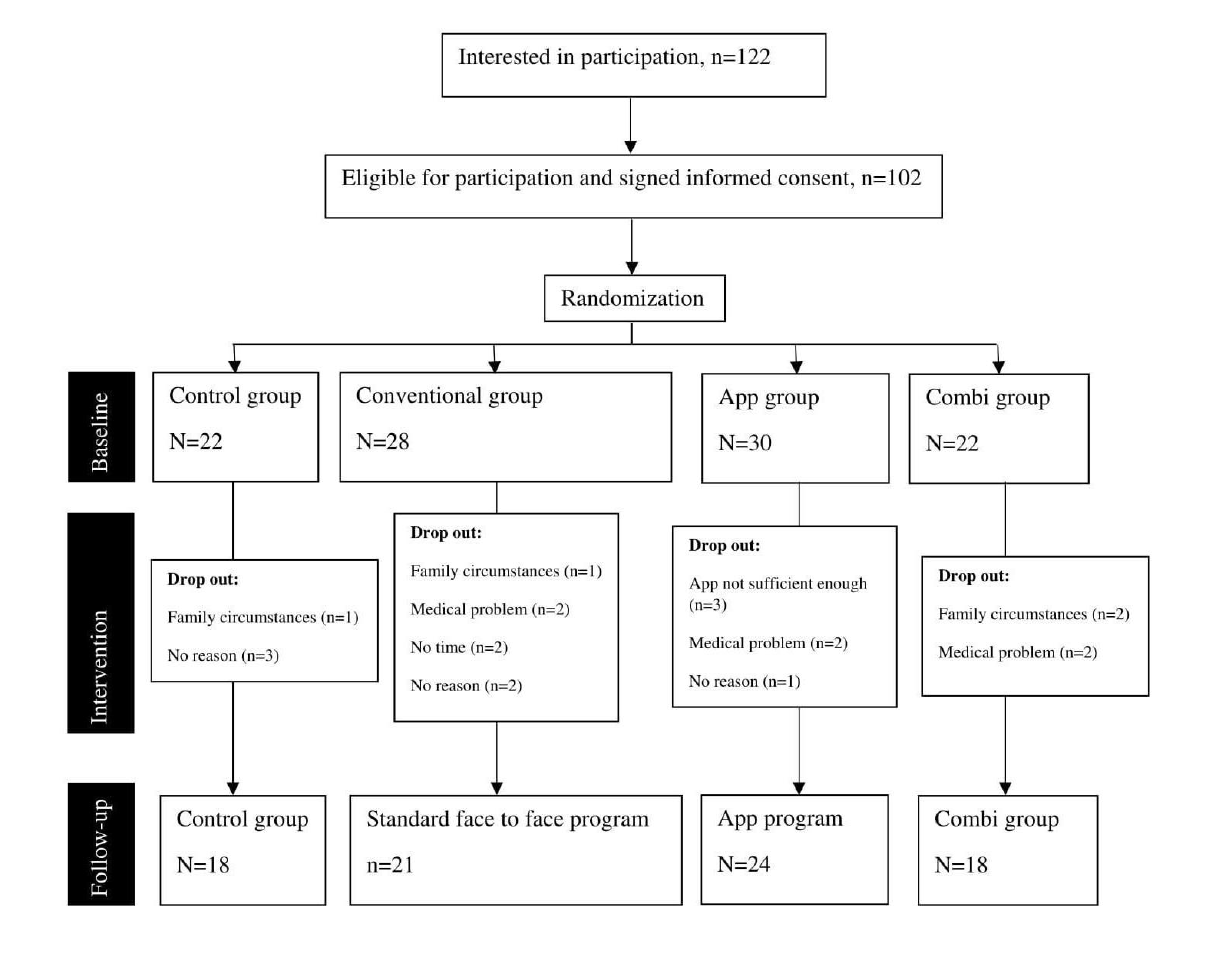
Figure 3. Flowchart of trial.